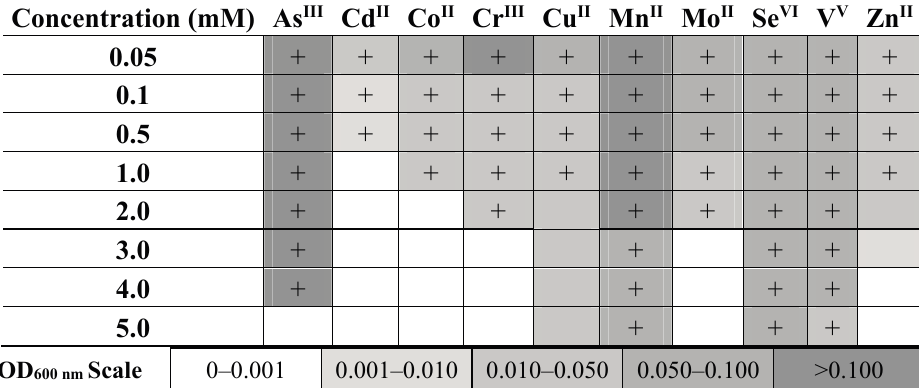
Table 3. Effect of heavy metals on growth and arsenic respiration. Heat map shows the inhibitory effect of heavy metals on anaerobic growth in minimal salt medium supplemented with 2.5 mM sodium arsenate and 5 mM sodium lactate. Each block represents culture density (OD 600 nm ) after 48 h of incubation; + represents complete arsenate reduction (determined by the silver nitrate